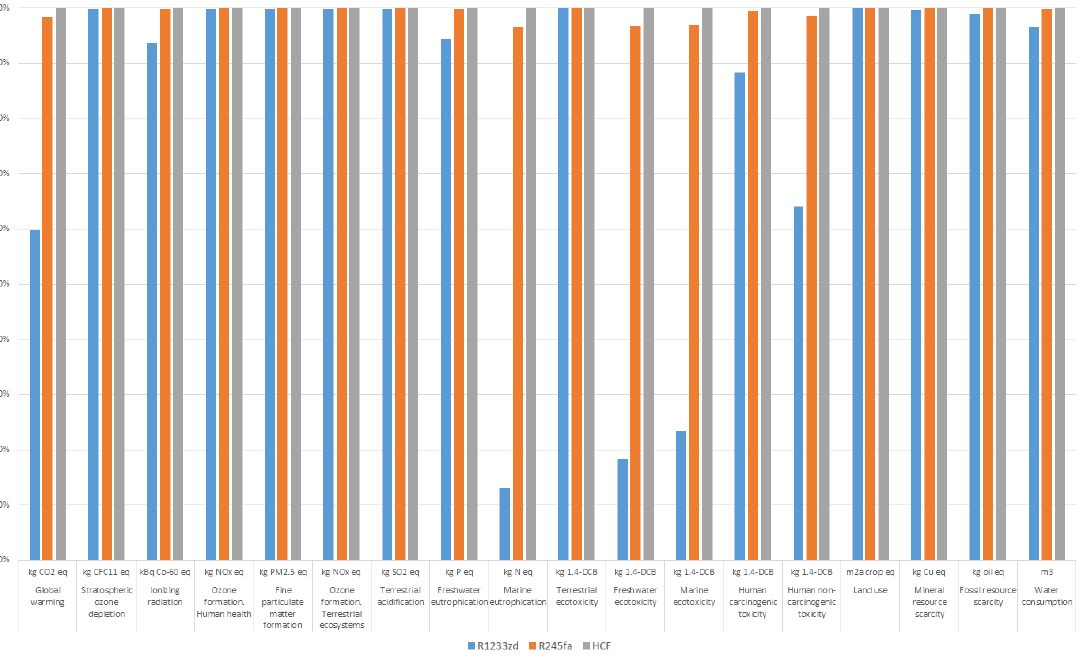
Figure 9. Comparisons of the life cycle impacts for three different organic fluids. Results are obtained with ReCiPe 2016—Midpoint (H)